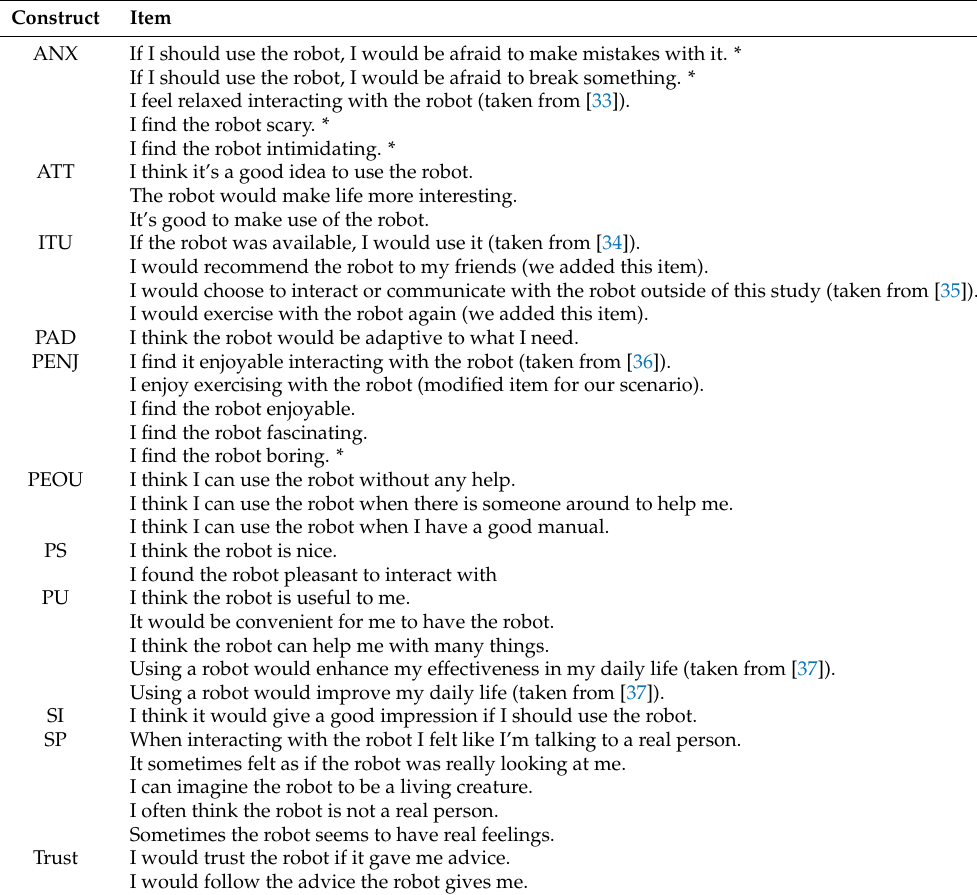
Table 1. The used acceptance questionnaire